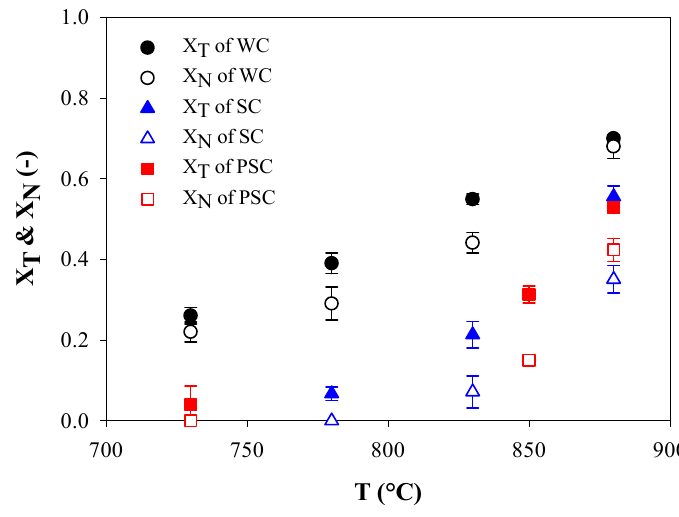
Figure 7. X T and X N from tar reforming over PSC, WC, and SC at different temperatures.